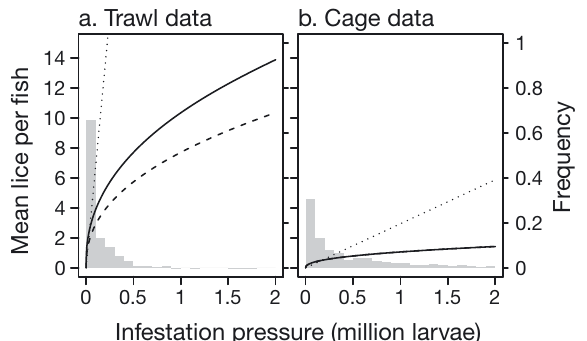
Fig. 2. Model predictions of mean number of lice per fish and calculated infestation pressure for fish in the (a) trawl and (b) cage data set. Lines (left y -axis scale) show expected number of lice per fish as a function of infestation pressure for an exposure duration of 7 d. Unbroken lines: predictions assuming 10 km d –1 post-smolt migration speed and esti- mated infestation pressure effect (main model). Dashed line in (a) assumes 7 km d −1 post-smolt migration speed (only rel- evant for trawl data). Dotted lines: assuming a fixed slope of 1 for the infestation pressure effect. Grey histograms (right y -axis scale) show the frequency distribution of infestation pressure among the fish in each data